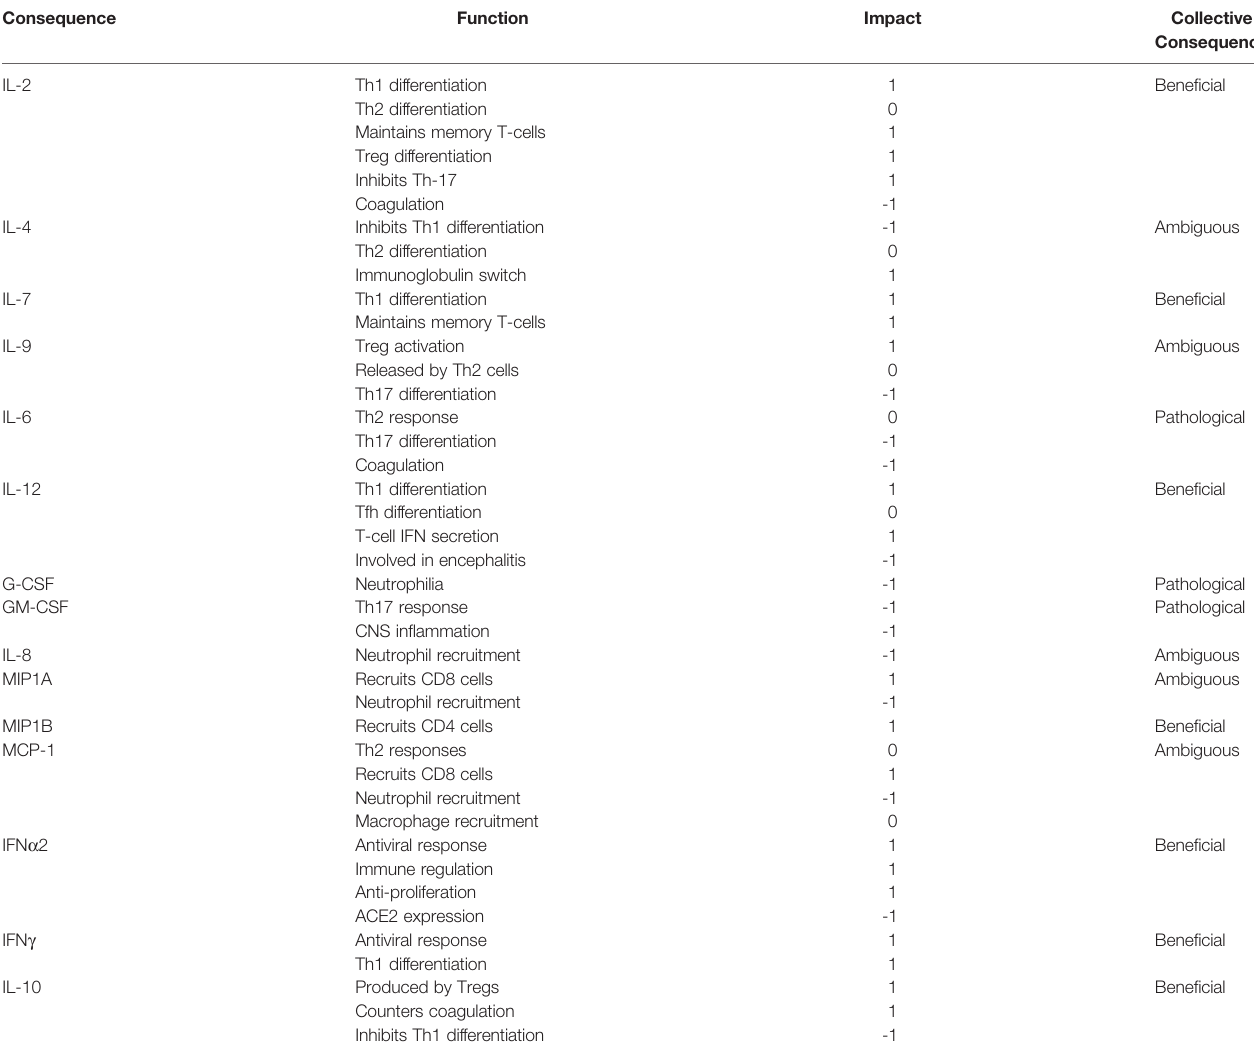
TABLE 1 | Predicted actions of JAK signaling cytokines in SARS-CoV-2 infection.